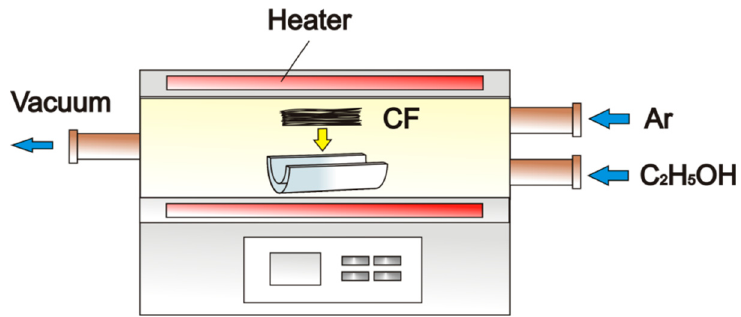
Figure 2. Schematic drawing of the chemical vapor deposition (CVD) method.